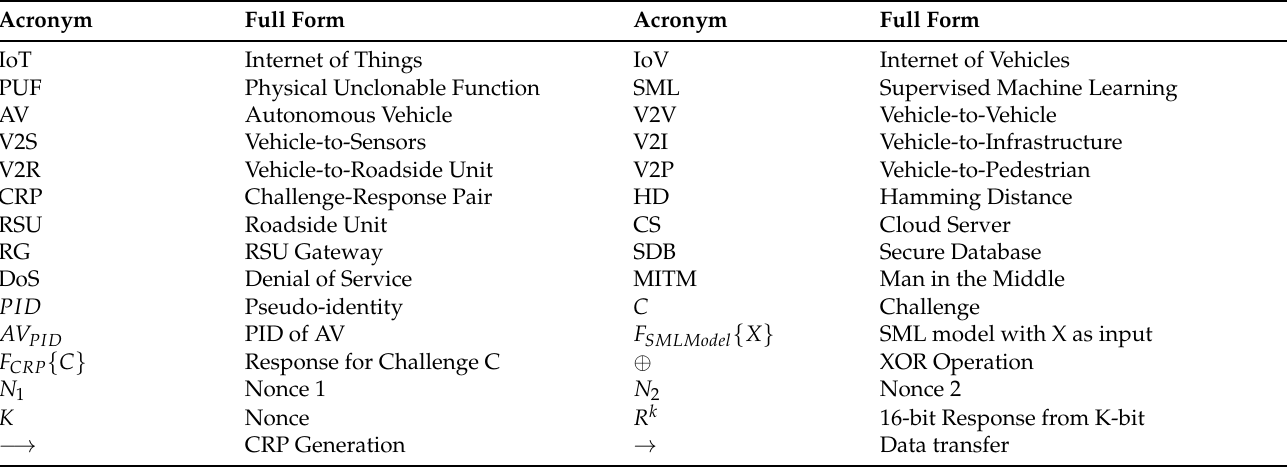
Table 1. Acronyms used in the